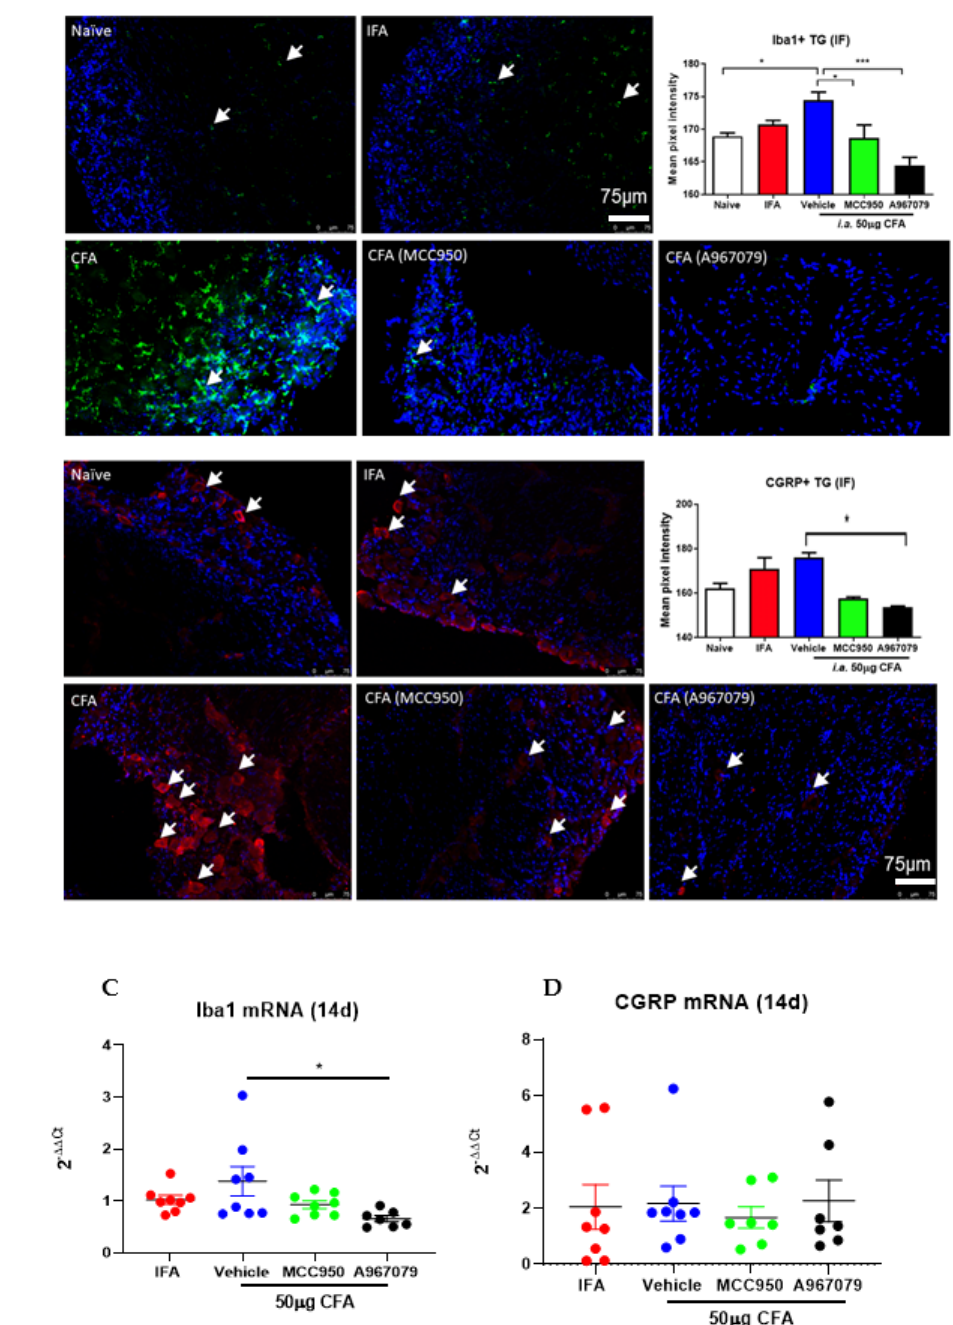
Figure 6. The effect on distinct alteration of CGRP and Iba1 protein and mRNA expression in TG collected at different timepoints post-CFA treatment. ( A ) Representative images and quantification of Iba1+ staining in naïve, IFA and CFA- treated animals collected at day 5 in absence or presence of the NLRP3 (MCC950) and TRPA1 (A967079) antagonists, showing significant reduction in Iba1 with both inhibitors ( B ) Representative images and quantification of CGRP+ staining in naïve, IFA and CFA-treated animals collected at day 5 in presence or absence of NLRP3 (MCC950) and TRPA1 (A967079) antagonists, showing that only A967079 significantly reduced CGRP expression in CFA treated mice. ( C ) Iba1 mRNA expression and ( D ) CGRP mRNA expression in TGs of IFA- or CFA-treated animals in absence of the NLRP3 (MCC950) and TRPA1 (A967079) antagonists. The TGs were collected at 14 days post-CFA treatment. n = 7 − 8 animals. The white arrows highlight the Iba1+ (green) or CGRP+ (red) staining. Scale bar = 75 µ m. Data represent mean ± SEM, ordinary one-way ANOVA with Tukey’s multiple comparisons test. Per group, * p < 0.05, *** p <